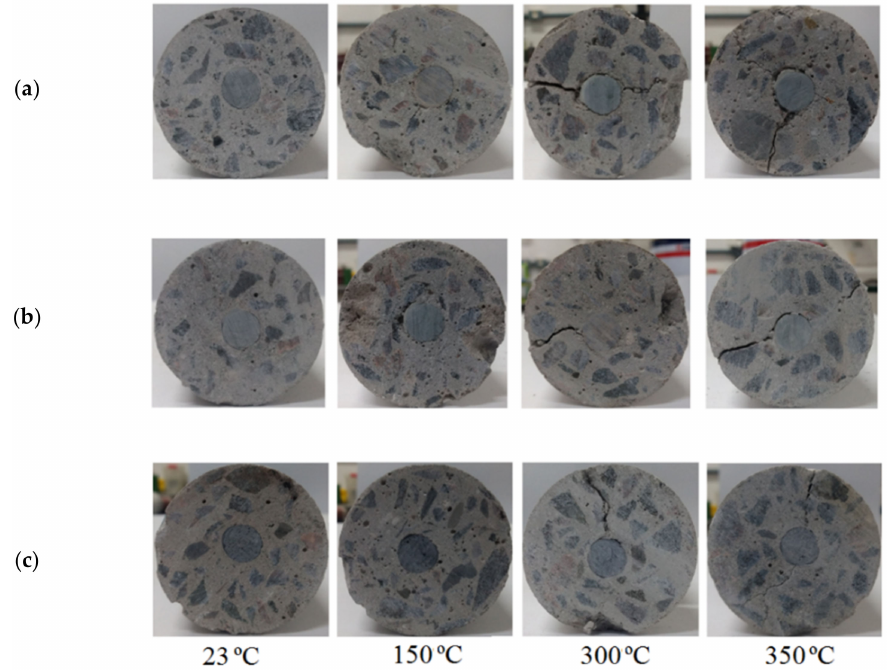
Figure 11. Transversal failure of concrete of samples: ( a ) GFRP P, ( b ) GFRP V, and ( c ) GFRP E at elevated temperatures. Table 6. ANOVA analysis results for GFRP-N and GFRP-Y samples tested at 23 ◦ C–300 ◦ C. Source of Variation SS d f MS F p -Value